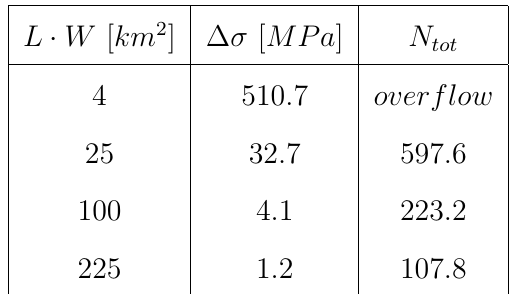
Table 6: Relation between fault parameters and aftershock production. The value of M is fixed at 6 . 0; the output grid is of 20 km × 20 km , the spacing is 0 . 5 km . The spacing on the fault is 0 . 05 km